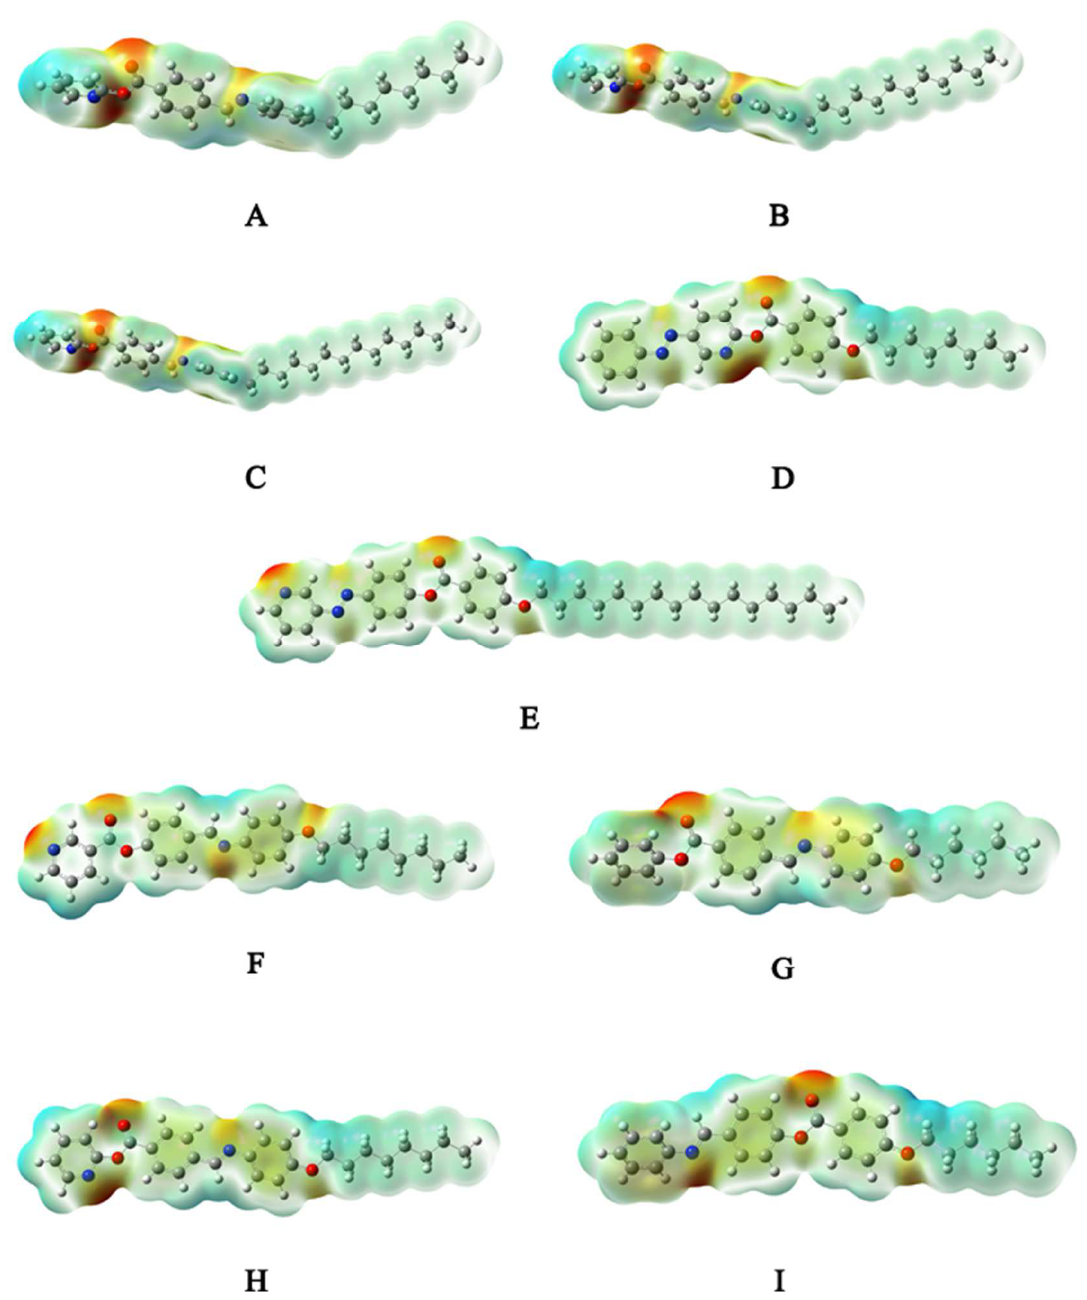
Figure 9. The estimated molecular electrostatic potentials (MEP) of A , B , C , D , E , F , G , H , and I compounds.